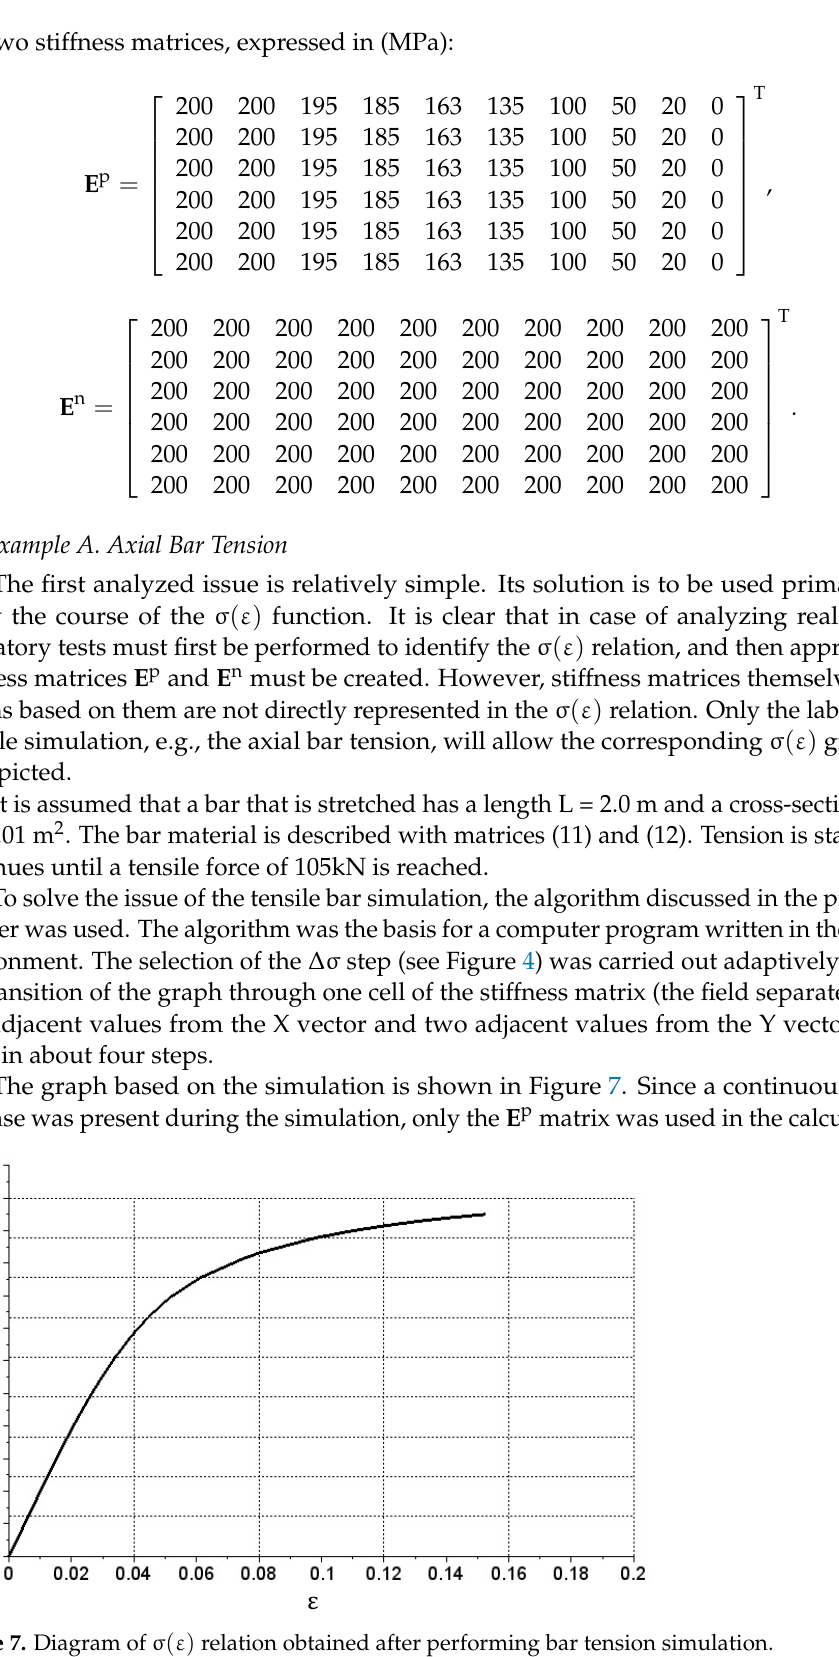
Figure 7. Diagram of σ(ε) relation obtained after performing bar tension simulation.